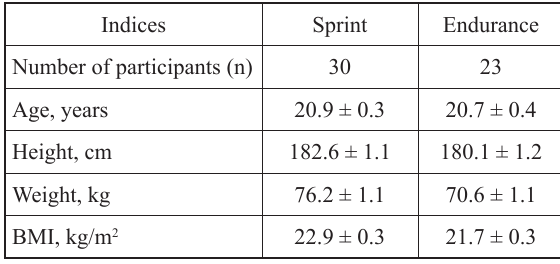
Table 1. Characteristics of research participants